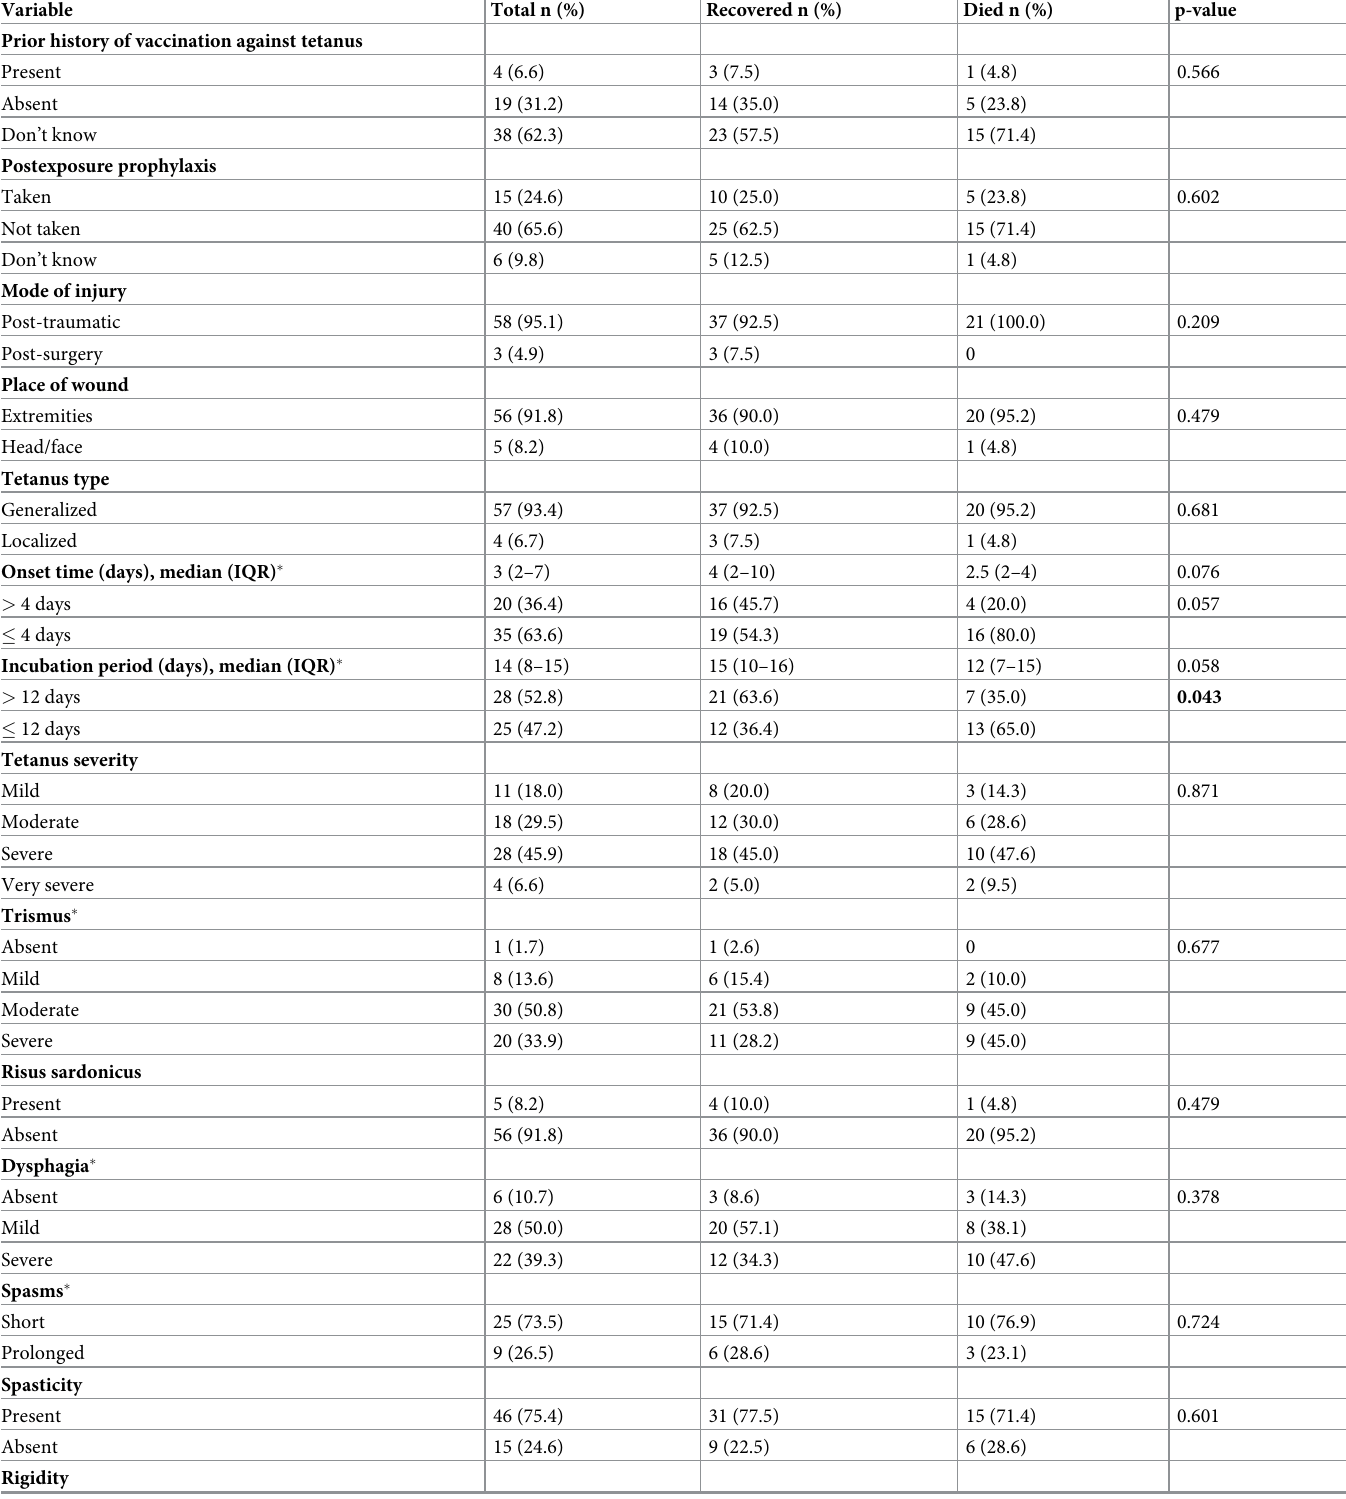
Table 3. Clinical characteristics of the patients (n =